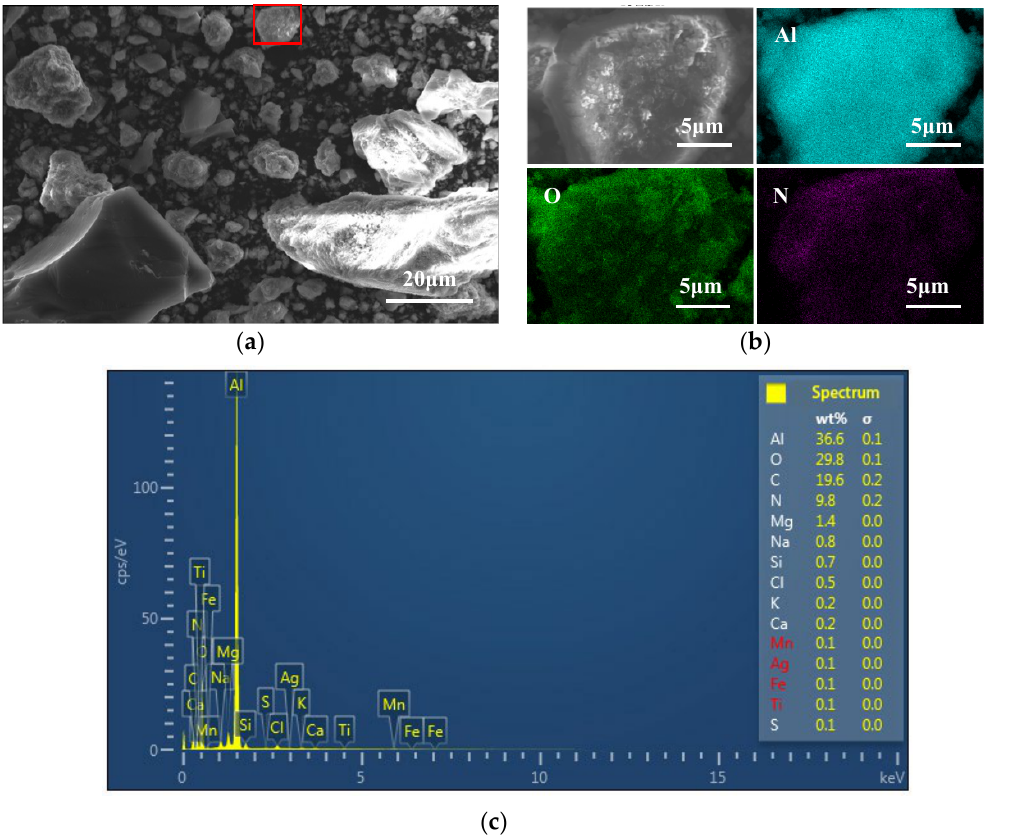
Figure 3. SEM-EDS image of original aluminum dross. ( a ) SEM of original aluminum dross; ( b ) SEM and micro-area element surface distribution of the red frame area; ( c ) EDS spectrum analysis of the red frame area.